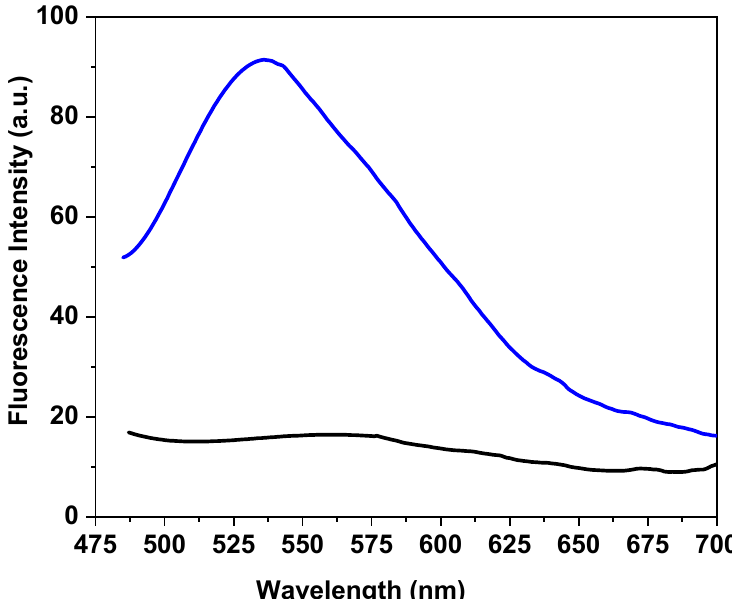
Figure 7. Comparison of the fluorescence spectra for the RC-4/CdSe-QDs@S-DAB 5 (blue line) and RC-4 (black line) films excited at 475 nm.